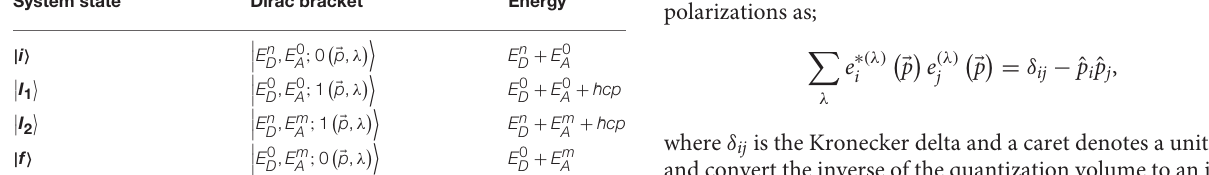
TABLE 1 | All the system states and their associated energies for RET. System state Dirac bracket